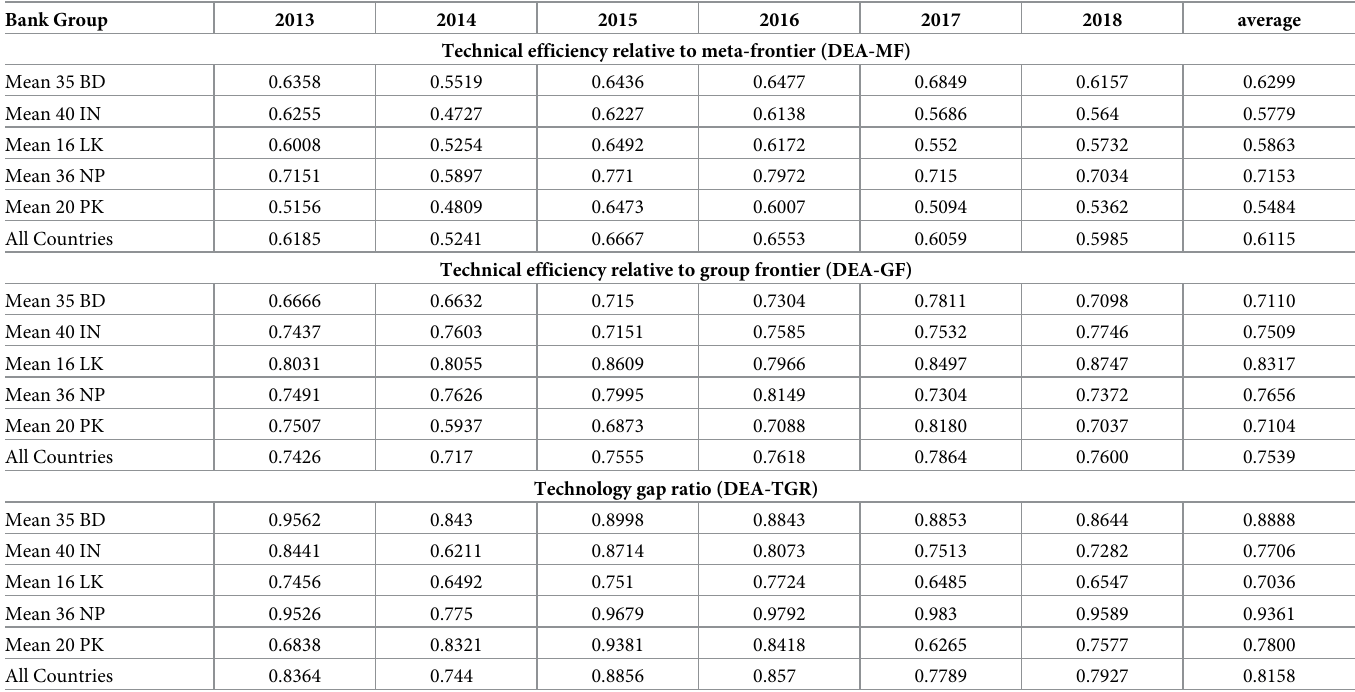
Table 6. Technical efficiency and technology gap ratio of DEA-meta frontier in South Asian countries.